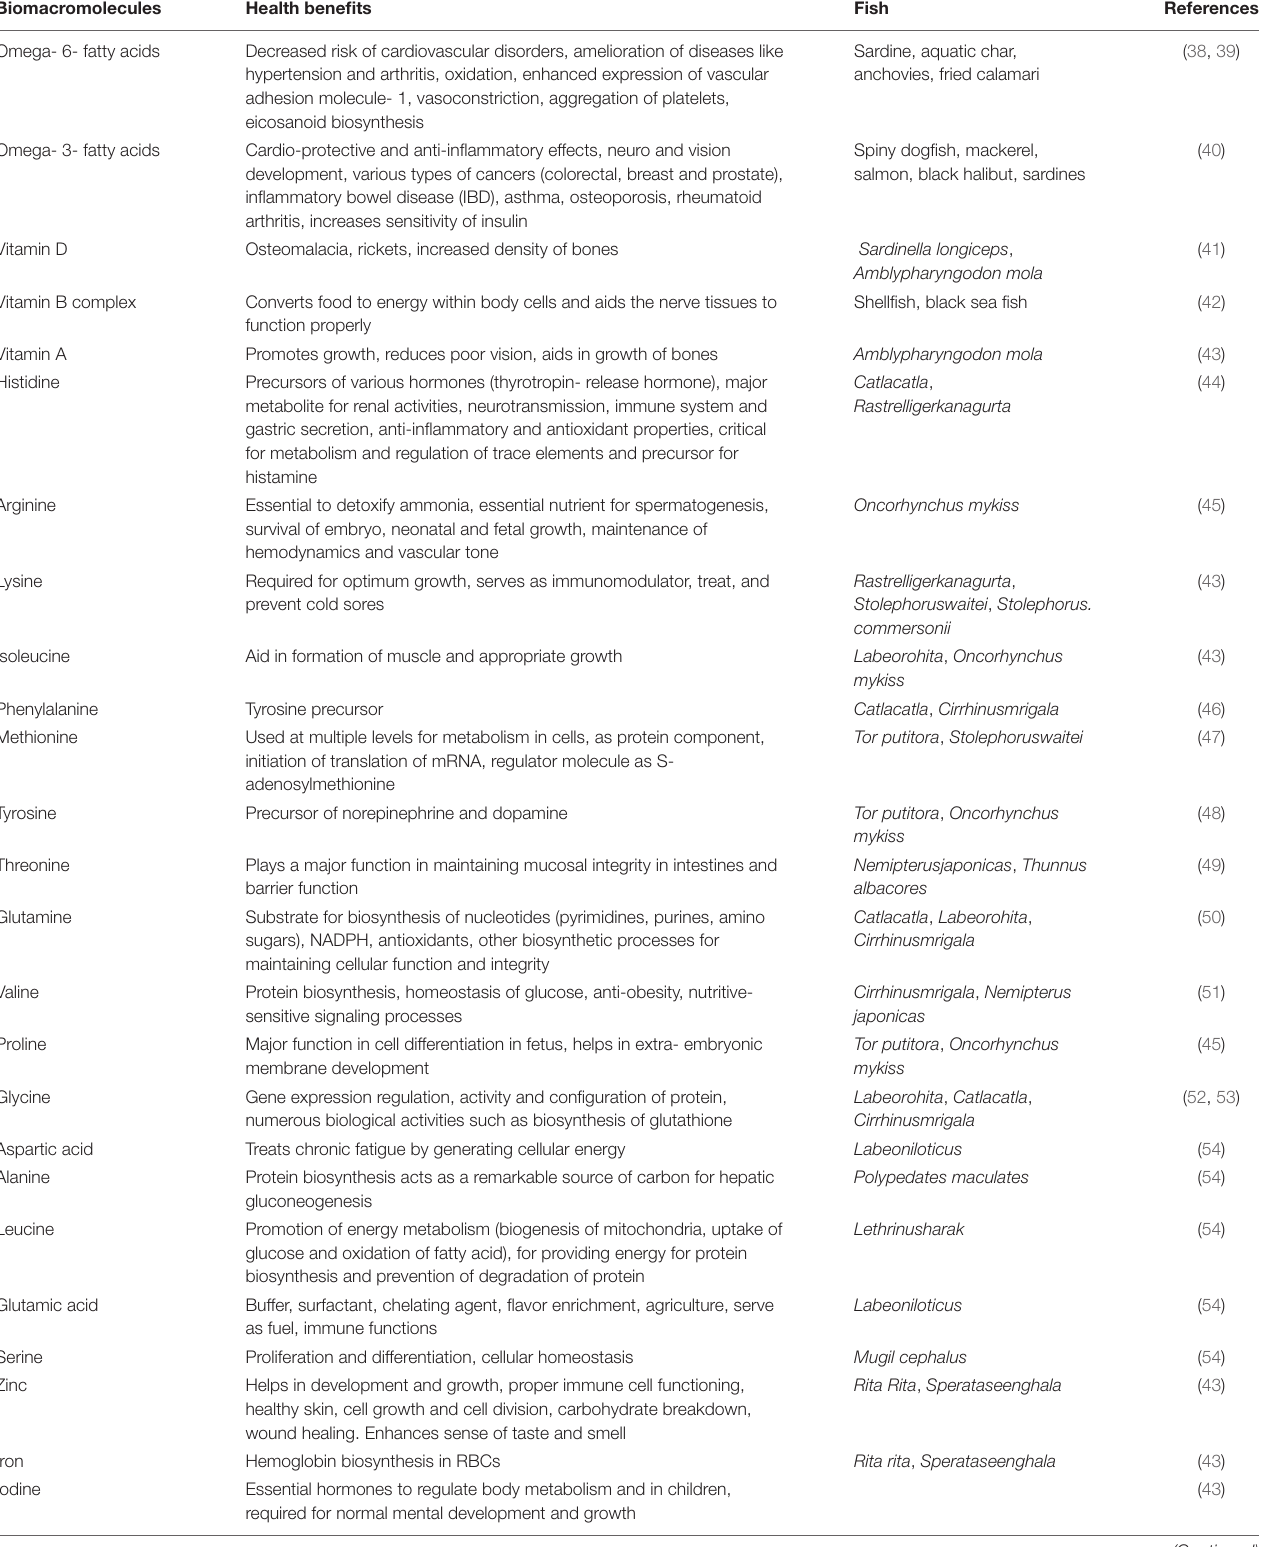
TABLE 1 | Biomacromolecules from various fish discards and their potential health